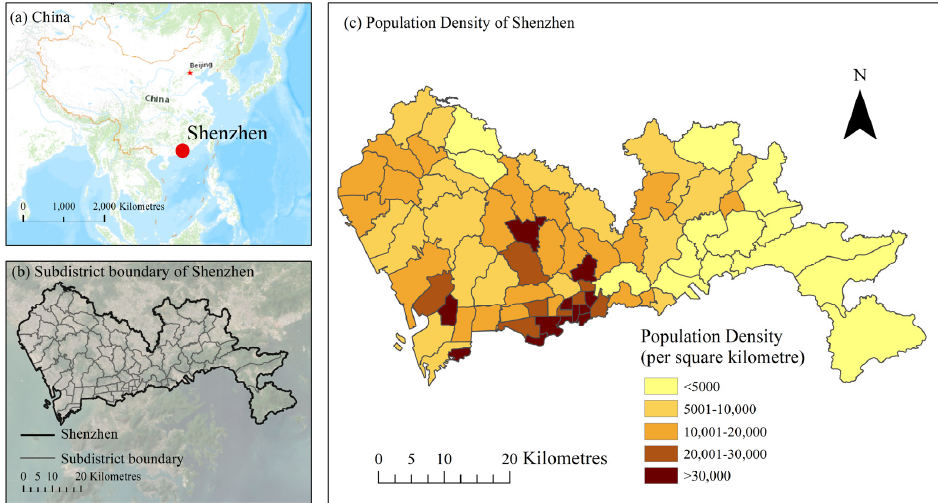
Figure 1. A dministrative subdistricts and their population density in Shenzhen. Figure 1. Administrative subdistricts and their population density in Shenzhen.